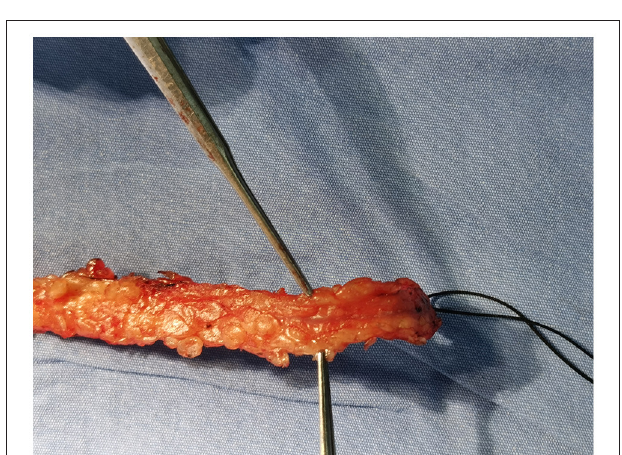
FIGURE 3 | No-touch technology.